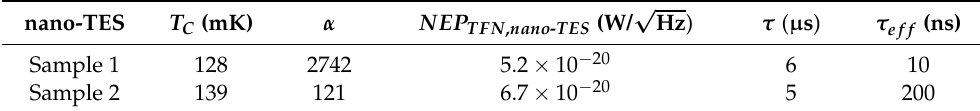
Table 1. Performance of nano-TES bolometers deduced from the experimental data reported in Section